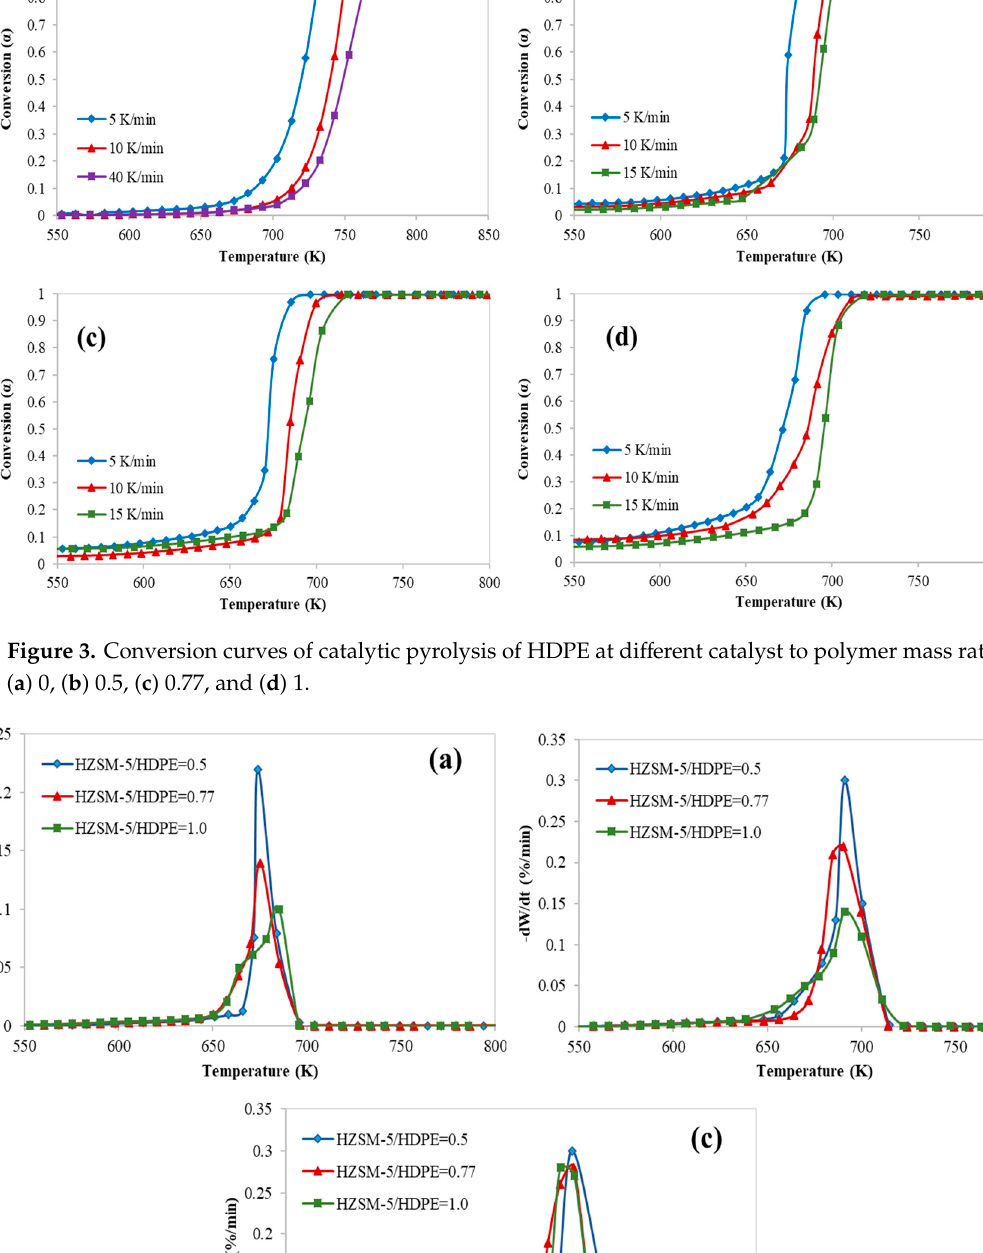
Table 5. Thermogravimetric analysis data.